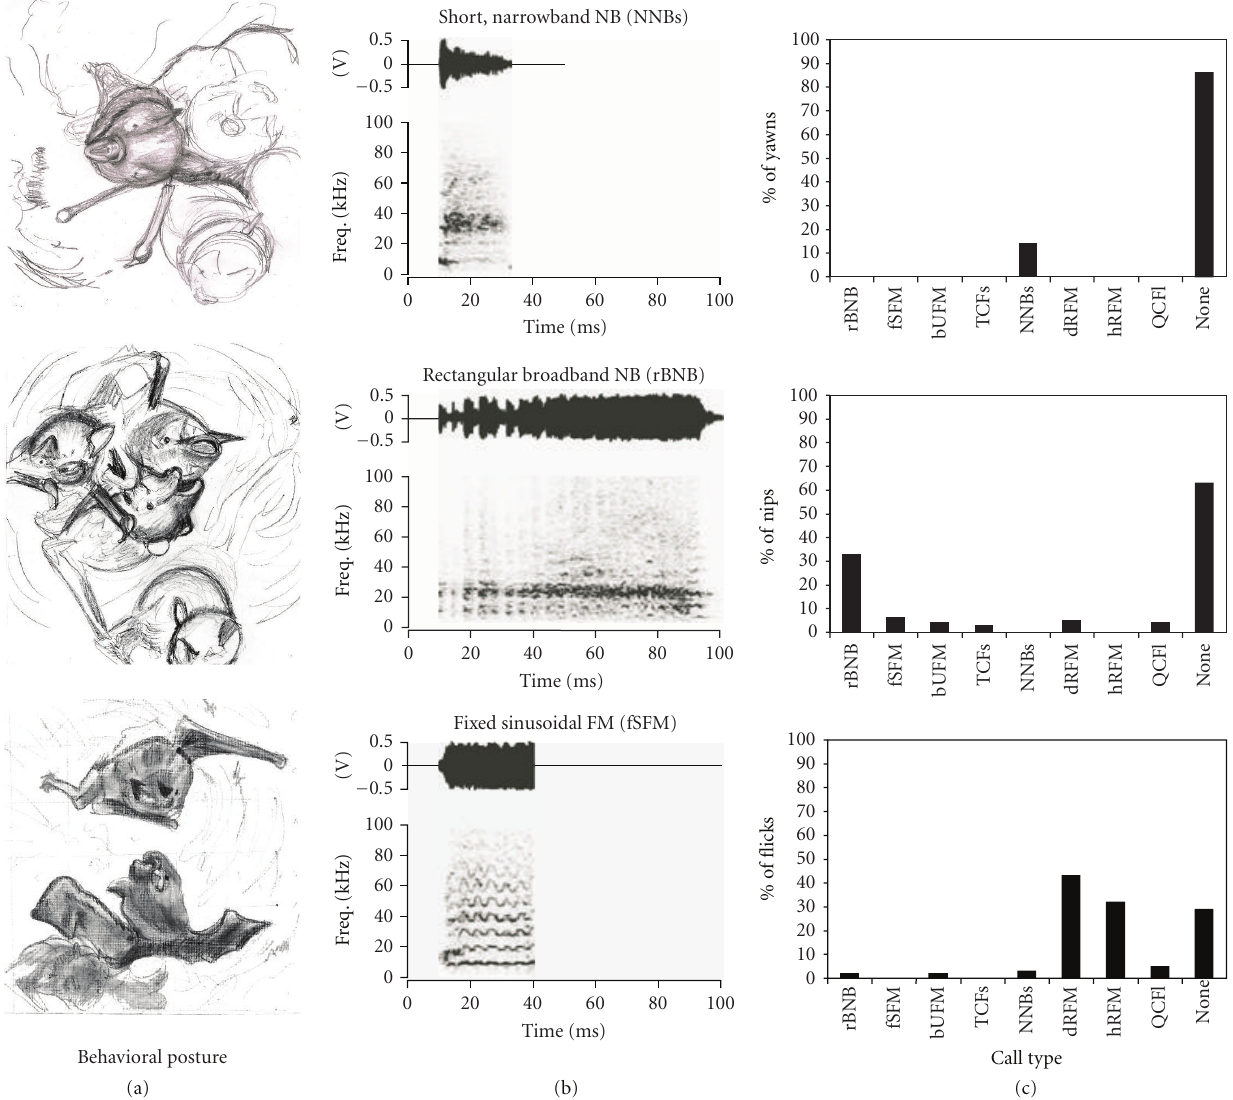
Figure 4: Association of social and vocal behavior in mustached bats. Left column shows sketches of common postures (left panel) and bar graphs (right column) to show the relative occurrence of di ff erent vocalizations associated with each behavior pattern. The middle panel shows amplitude envelopes (above) and spectrograms (below) of simple syllabic calls associated with each behavior. (a) Yawning. (b) Nipping. (c) Two bats flicking their wings at each other. Abbreviations: Freq. = frequency; V =